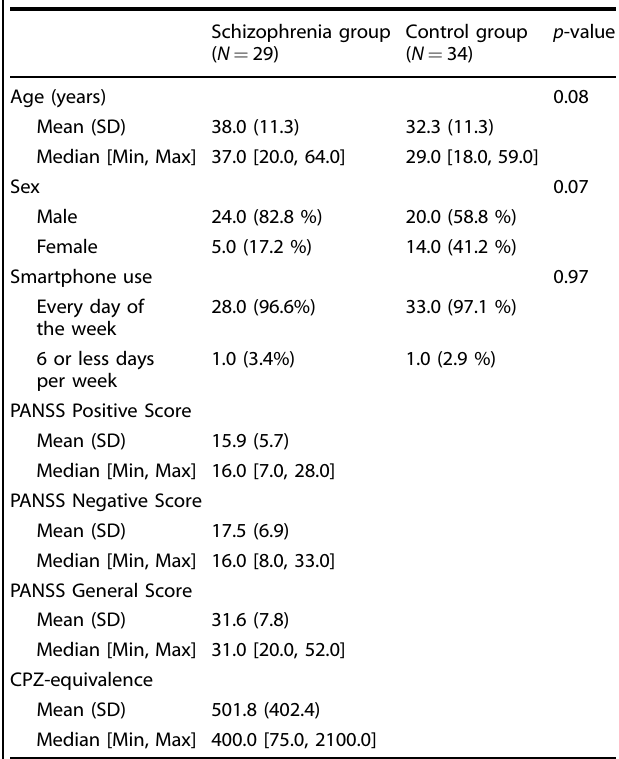
Table 1. Demographic and clinical data for schizophrenia and control groups from the fi nal sample.